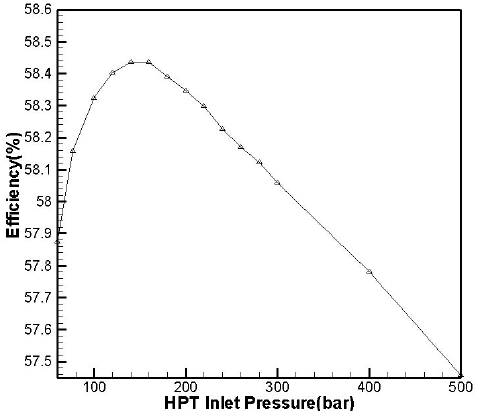
Figure 7. Effects of high-pressure turbine (HPT) inlet pressure on efficiency.